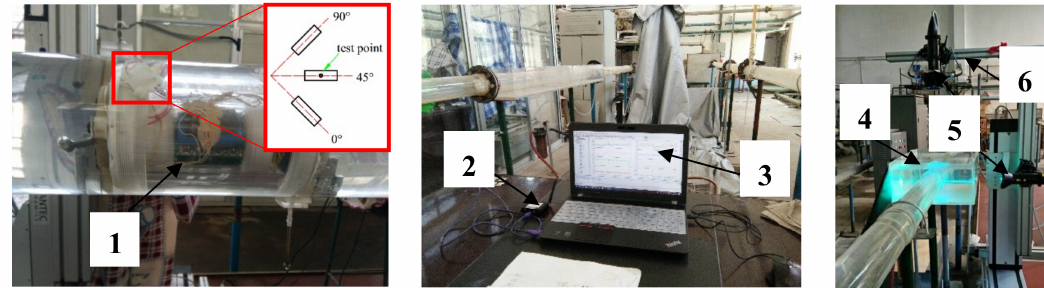
Figure 5. Experimental devices and instruments. Note: 1—Main engine of force measurement system; 2—Gateway of force measurement system; 3—System software TSTDAS V5.0; 4—Square water jacket; 5—Probes of LDV; 6—Coordinate